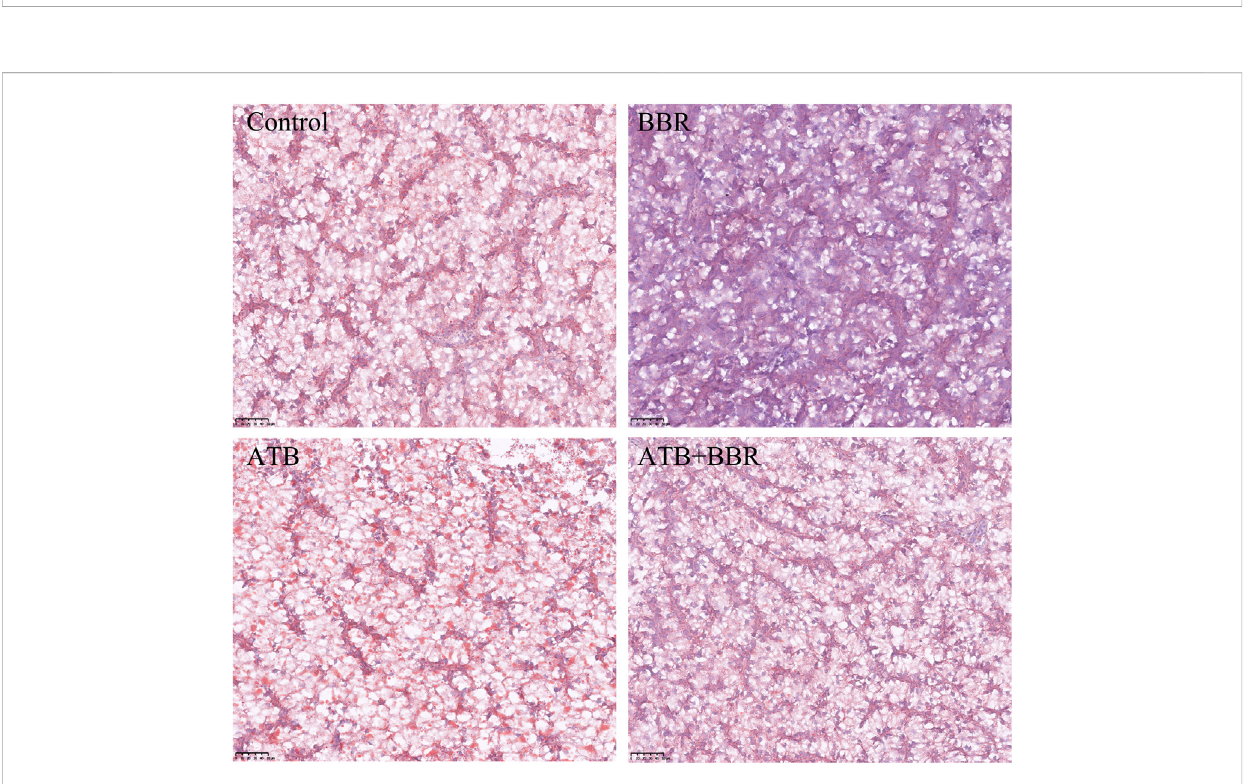
FIGURE 5 Oil red staining of largemouth bass liver (×10). The red colour in the picture represents lipid drops. BBR, berberine; ATB,